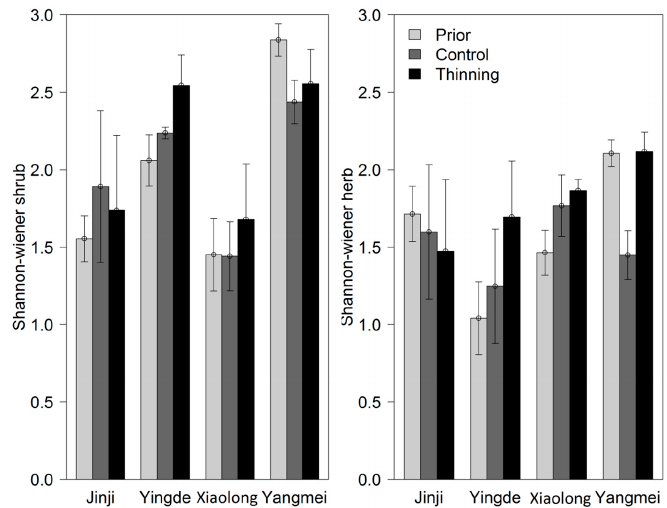
Figure 6. The shrub Shannon-Wiener index and herb Shannon-Wiener index for different manage- ment types.